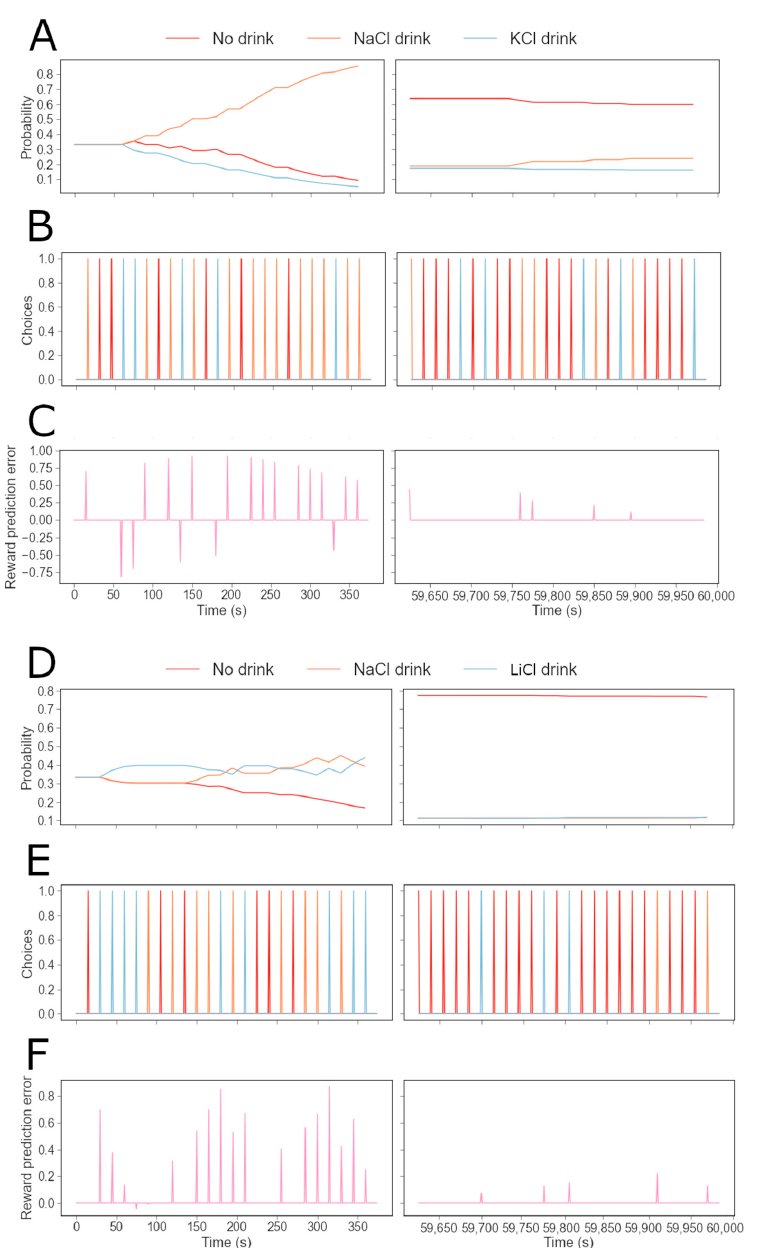
Figure 5. Example data for two simulated rats taking the two-bottle intake test developed by Fortin and Roitman (2018) during an extended period of time, divided into several sessions. Both versions of the experiment last 1000 min (4000 trials), divided into 200 sessions of 5 min (20 trials). ( A ) Evolution of the probability for an individual simulated rat with optimized free parameters to drink NaCl, KCl or nothing over time during the first (left) or last session (right). ( B ) Choices between drinking NaCl, KCl and nothing over time during the first (left) or last session (right). ( C ) Reward prediction error signal over time during the first (left) or last session (right). ( D ) Evolution of the probability to drink NaCl, LiCl or nothing over time during the first (left) or last session (right). ( E ) choices between drinking NaCl, LiCl and nothing over time during the first (left) or last session (right). ( F ) Reward prediction error signal over time during the first (left) or last session